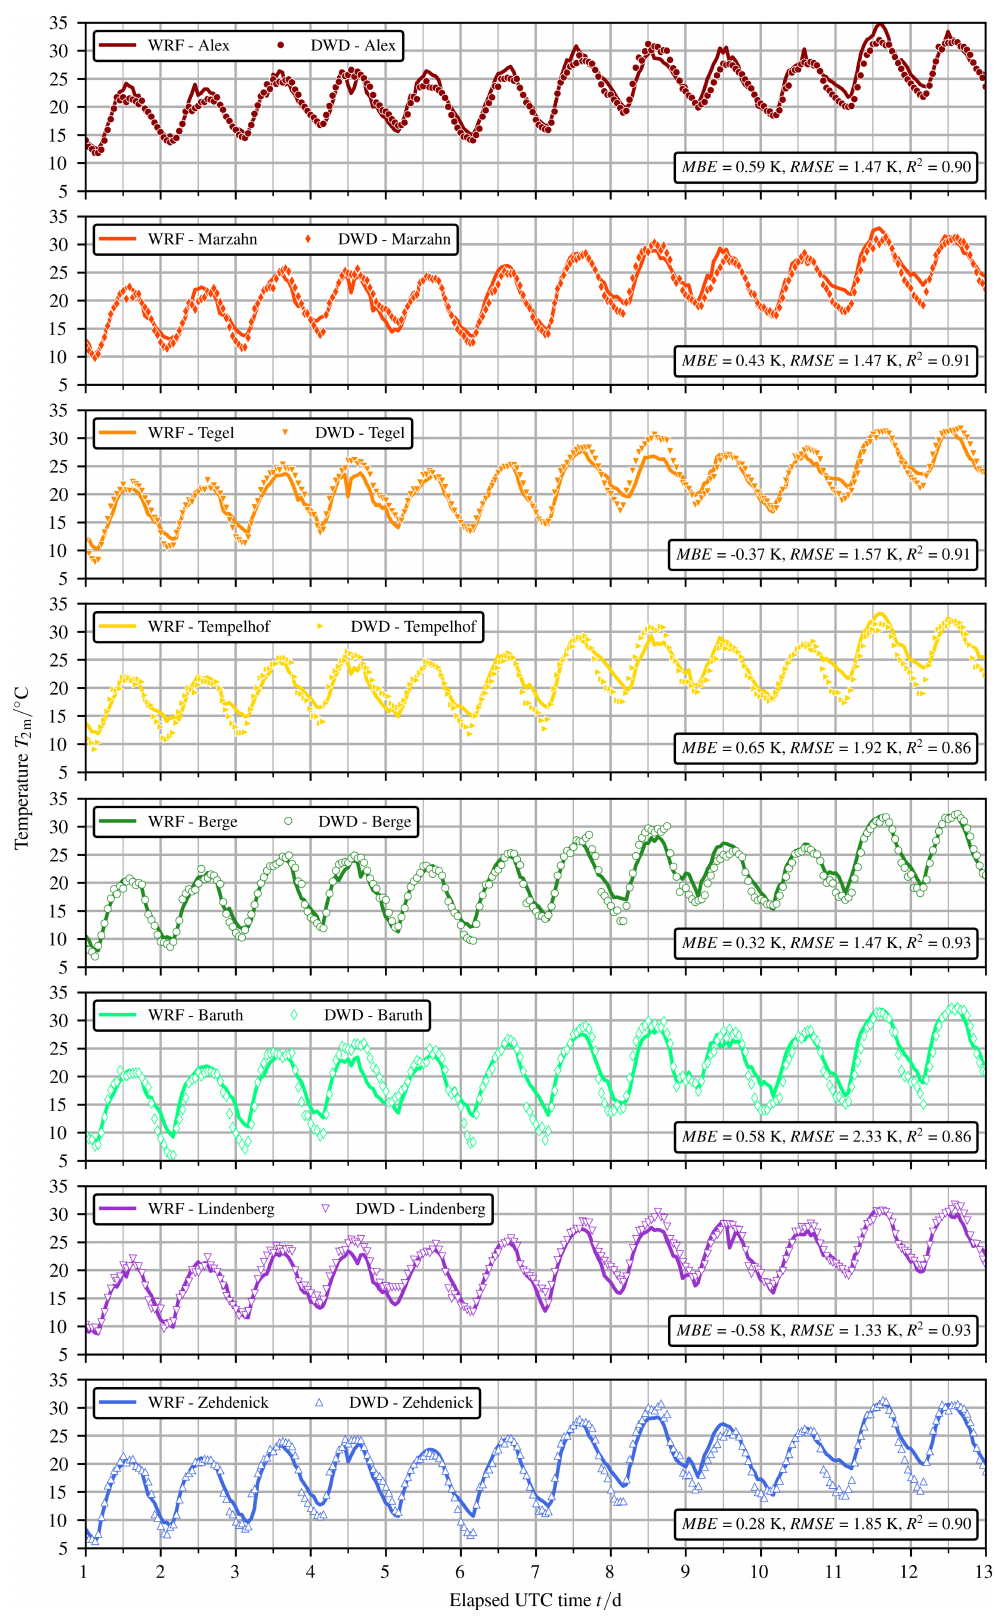
Figure 5. Comparison of simulated and measured T 2m at the probe locations of the four urban DWD measurement stations (Alexanderplatz, Marzahn, Tegel and Tempelhof) and the four rural DWD measurement stations (Berge, Baruth, Lindenberg and